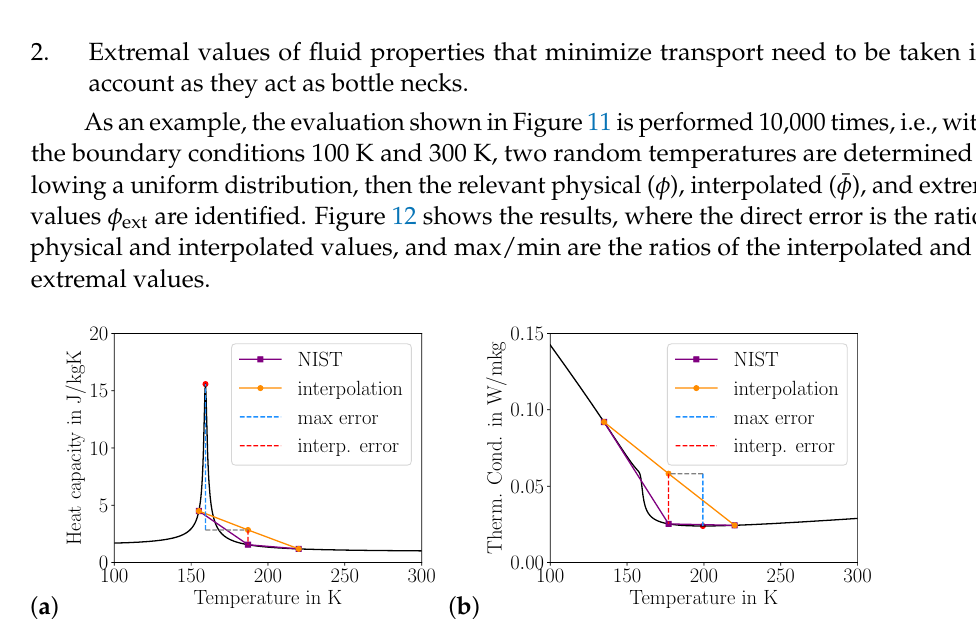
Figure 11. Illustration of error from underresolved sampling of non-monotonous fluid properties. ( a ) isobaric specific heat capacity c p ; ( b ) thermal conductivity k . The black solid line is NIST reference data; the orange circles in ‘interpolation’ mark sample positions in a mesh, where the middle value ¯ φ is ( φ ( T − )+ φ ( T + )) ; the purple square ‘NIST’ marks the interpolation of the available mesh values ¯ φ = 1 2 ( T − + T + )) ; the evaluation of the property ˆ φ from NIST data at the average temperature, i.e., ˆ φ = φ ( 1 2 the red circle marks the local maximum ( c p ) or minimum ( k ), the interpolation error (dashed red) is the difference between ¯ φ and ˆ φ , the max error (dashed blue) marks the difference between ¯ φ and the maximum ( c p ) or minimum ( k ) value φ ext .